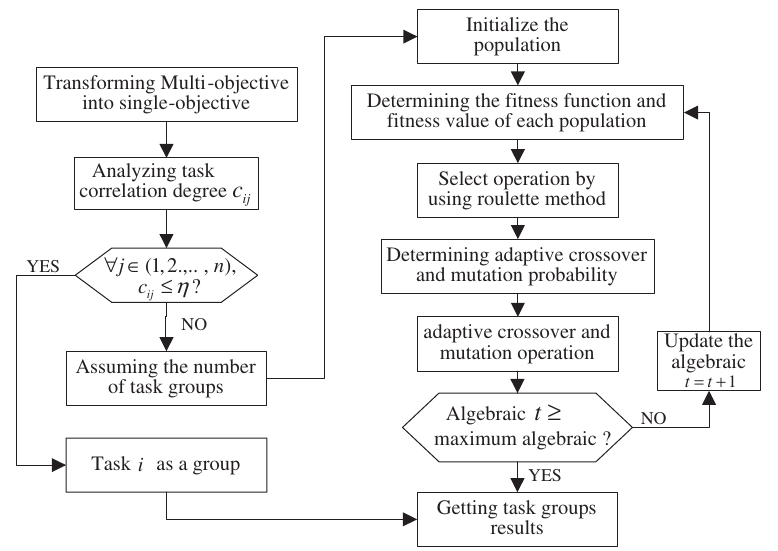
Figure 4: The Process of Model